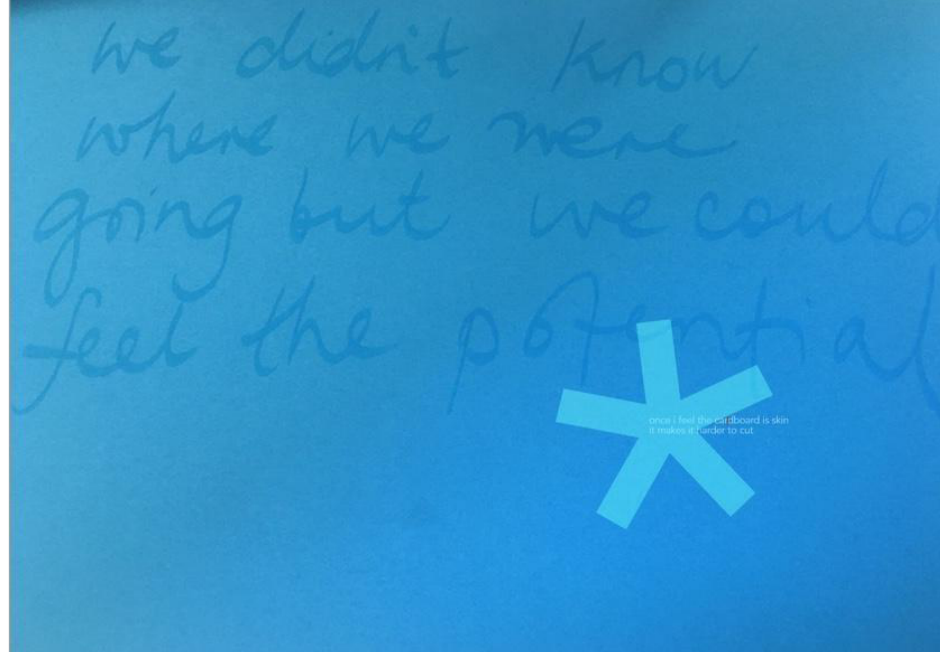
Figure 12: Page from Language is An Intangible Bridge Workshop Workbook, designed by pavleheidler and Alys Longley, with contributions by participants in the Language is An Intangible Bridge Workshop, hosted by CCOV Montreal